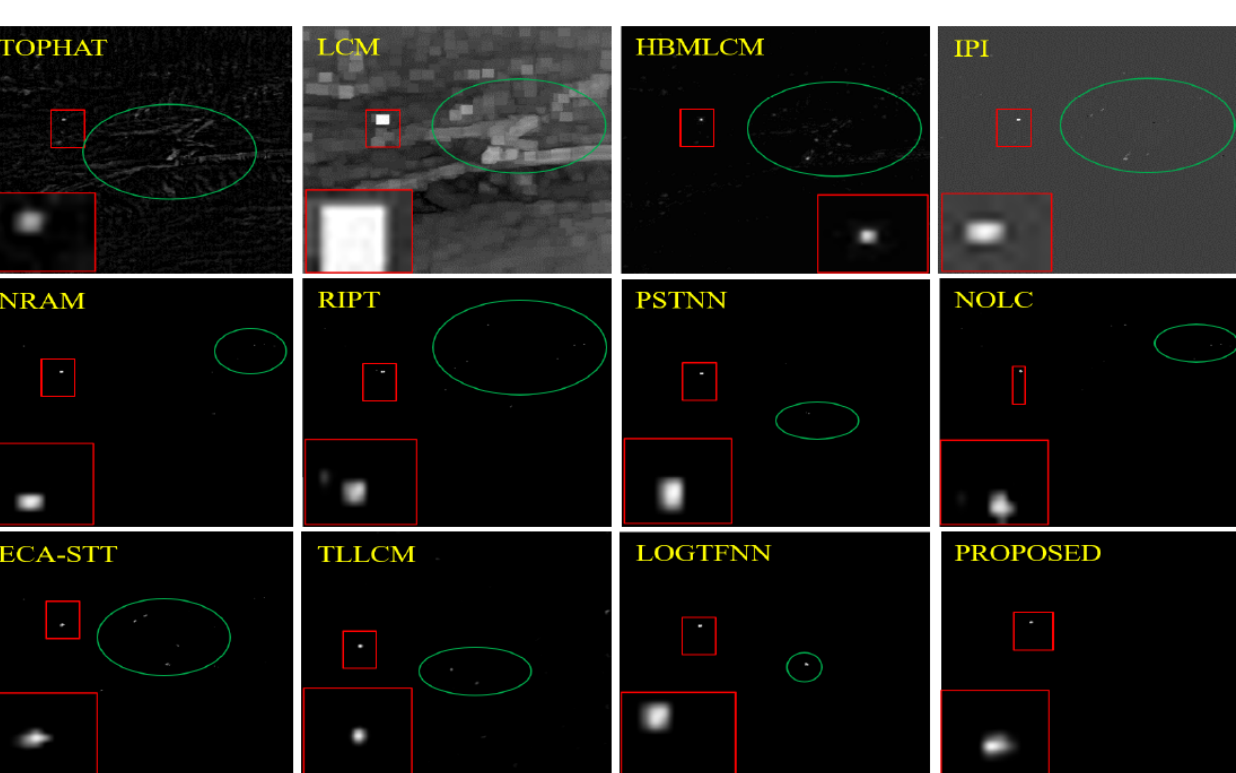
Figure 25. The detection results of data